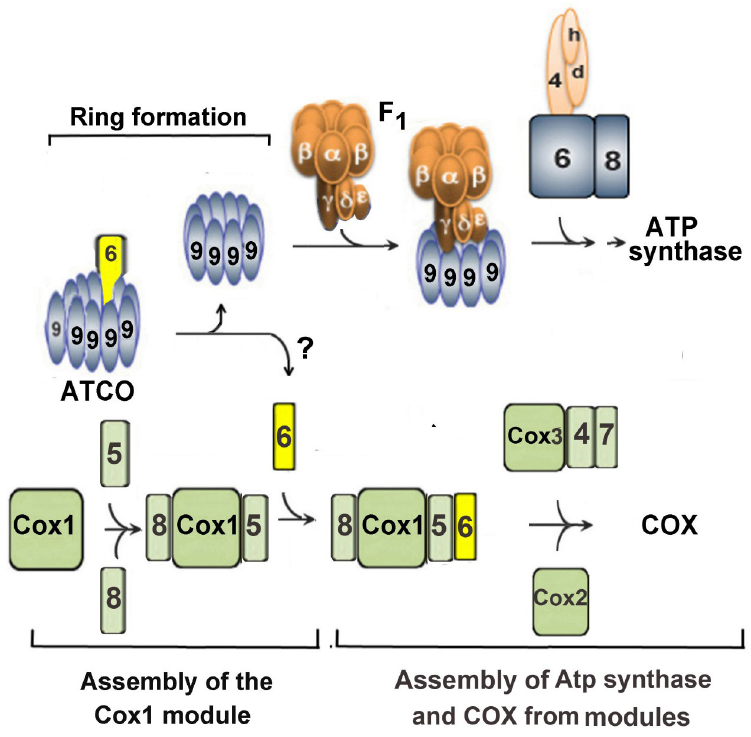
Fig 7. Model of the role of Atco complexes in coordinating assembly of cytochrome oxidase and ATP synthase. Atco is shown to co-regulate assembly of ATP synthase and cytochrome oxidase by supplying Cox6 and mitochondrially translated Atp9 to the respective